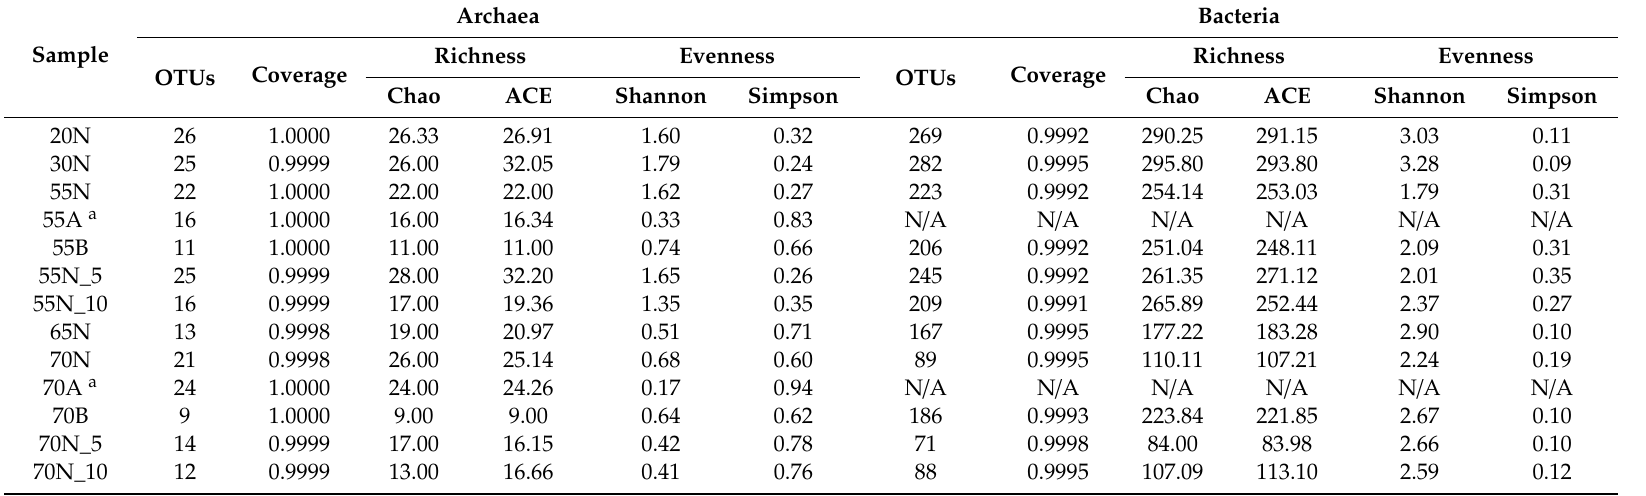
Table 2. Sequencing results and alpha diversity indices of the archaeal and bacterial